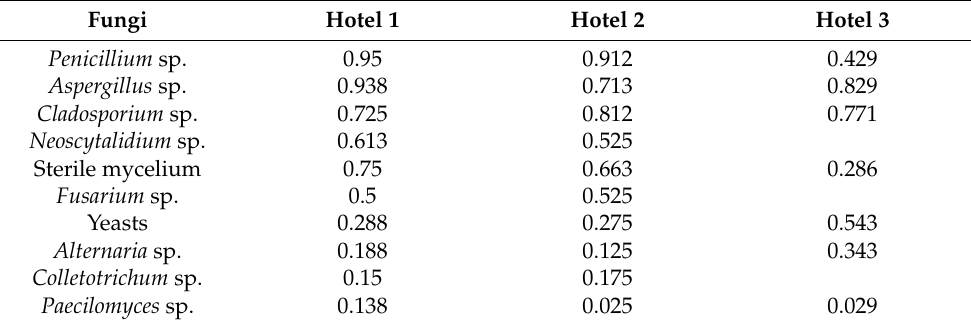
Table 3. Frequencies of fungi regardless of their concentration (Number of rooms where fungi appeared/total of